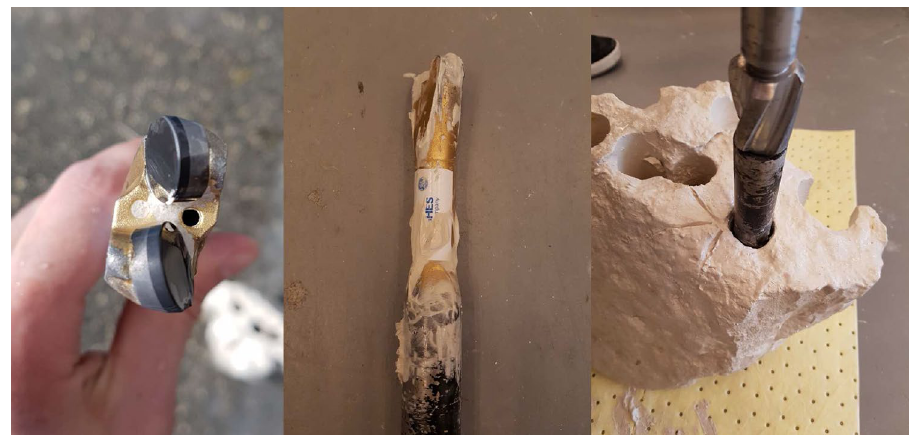
Fig. 8 From left: Plugged noz- zle, bit balling paste, well hole diameter being on gauge with bit diameter